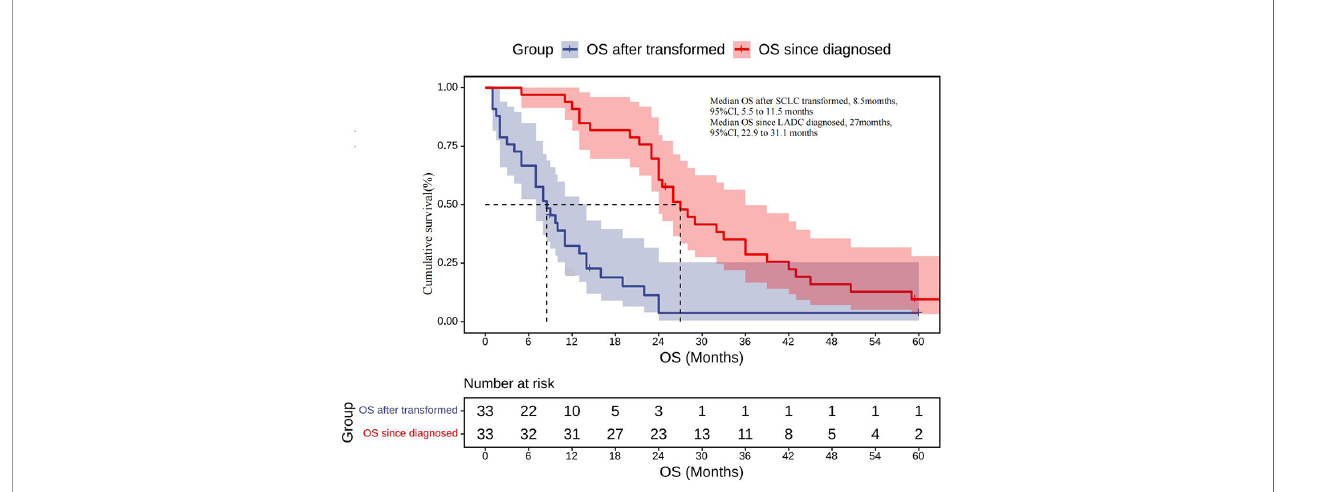
FIGURE 9 | OS after being transformed: Kaplan – Meier estimates of OS since the time of SCLC transformation; OS since diagnosed: Kaplan – Meier estimates of OS since the time of diagnosis. OS, overall